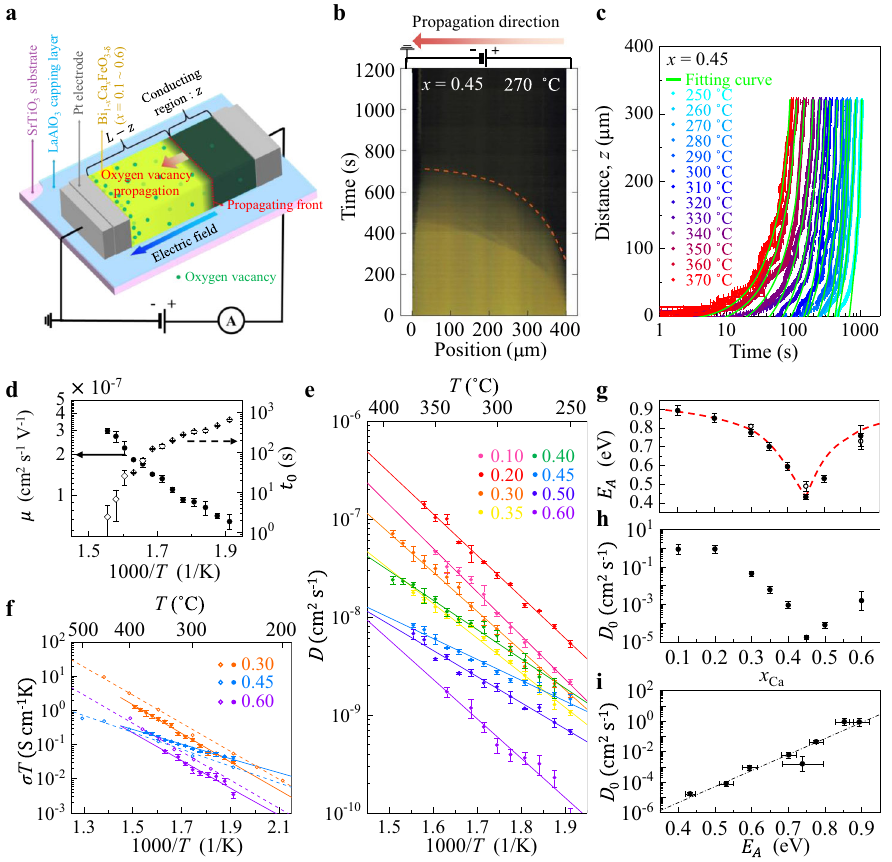
Fig. 1 | Real-time observation of V O migration in BCFO fi lms. a Schematic of a BCFO channel protected by a LaAlO 3 capping layer with a pair of 400- μ m gapped coplanar electrodes. Optical microscopic video and real-time current were simul- taneouslymonitoredwhileaconstantvoltagewasapplied. V O smigratedtowardthe ground electrode, thereby extending a conducting dark-colored formed phase. b Time evolution ofthe opticalcontrastalong the centerline ofthe channelduring the electroforming process at x Ca = 0.45. The orange dashed line represents the boundarybetweentheintermediatedark-yellowphaseandthecompletely-formed dark-coloredphase. c Trajectoriesoftheboundarypositionasafunctionofelapsed time at selected T s. Horizontal and vertical error bars represent the full-width-at- half-maximum (FWHM) of differential color change Gaussian pro fi les along the positionand timecoordinates. The green fi tting curves indicate that the simpli fi ed